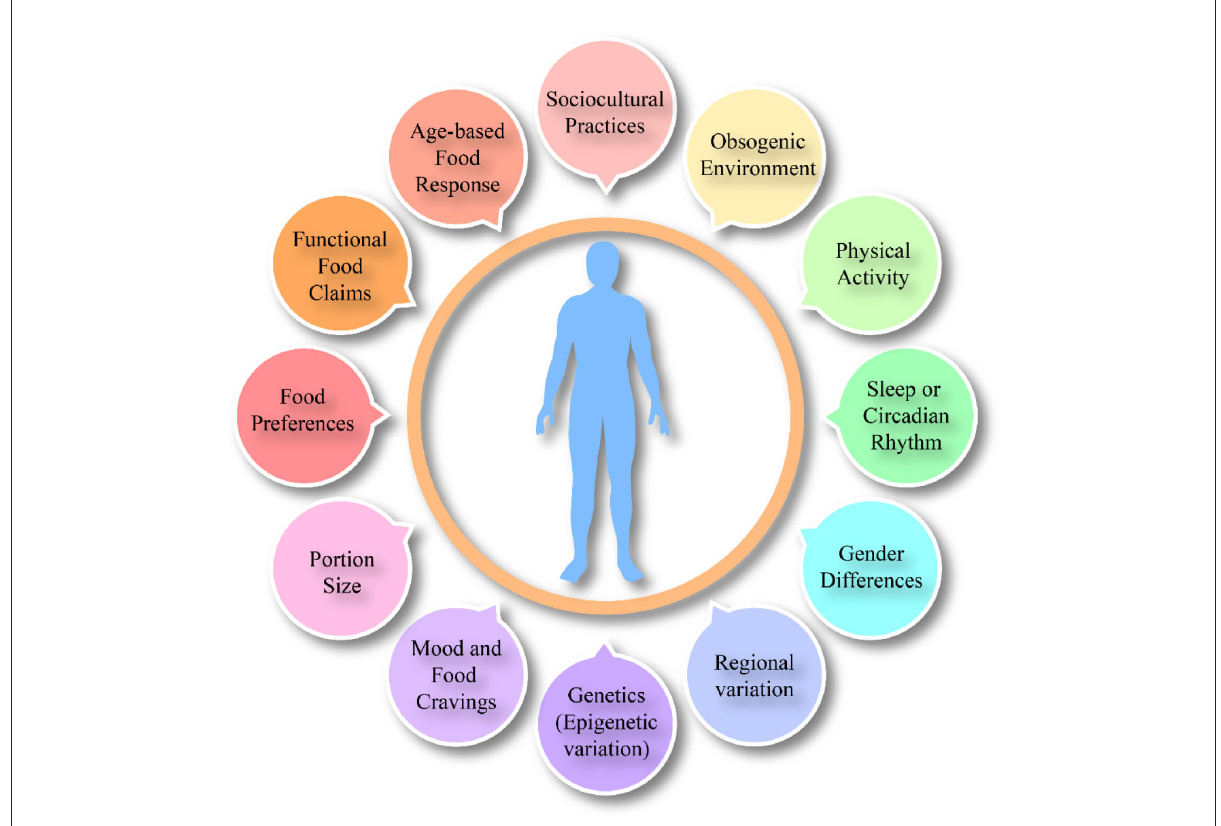
FIGURE3 Overall external factors affecting food intake, satiation and